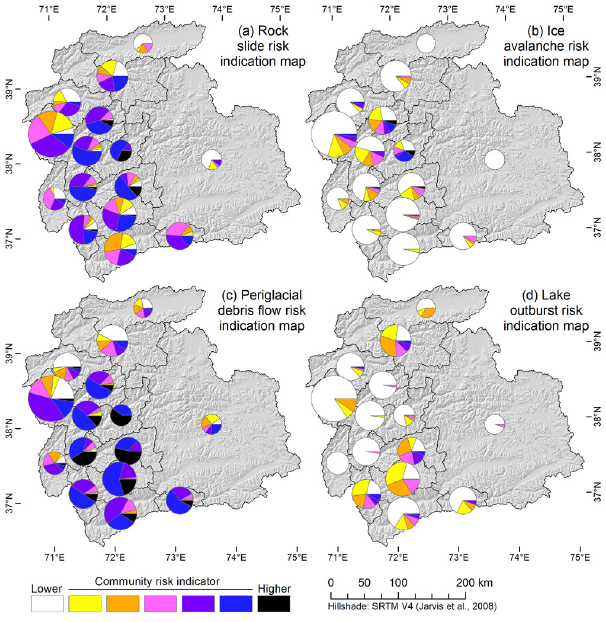
Fig. 10. Community risk indicators, generalized to 15 regions. For each region, the pie chart illustrates the relative abundance of the different community risk indicator classes. The size of each chart is proportional to the number of communities it represents.